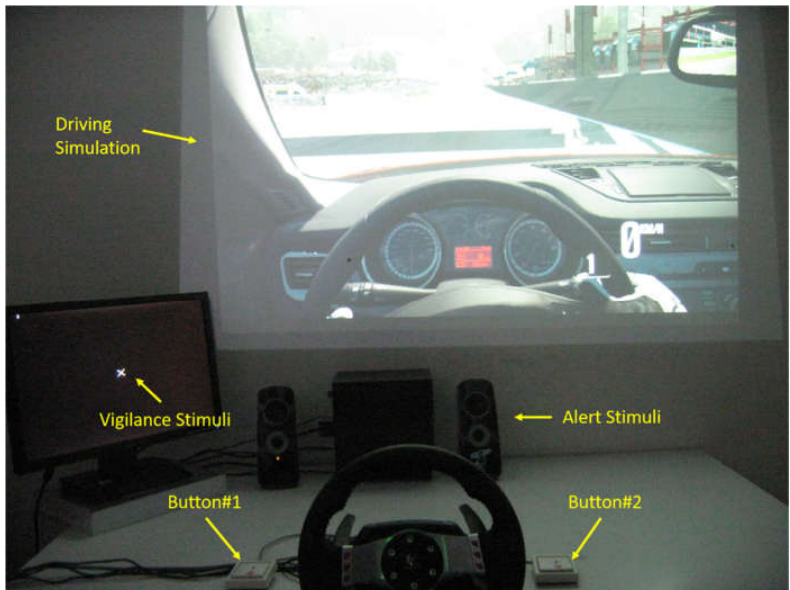
Figure 1. Experimental settings. (The experiment established five different Attentional and Vigilance tasks (TAV) to gradually increase the workload of the brain, allowing the subjects to drive a simulated car on the circuit under the same other conditions. When a white X appeared on the screen, subjects were asked to press Button#1, which represents “Vigilance Stimuli”. When the sound monitor emitted a stimulus, subjects were asked to press Button#2, which represents “Alert